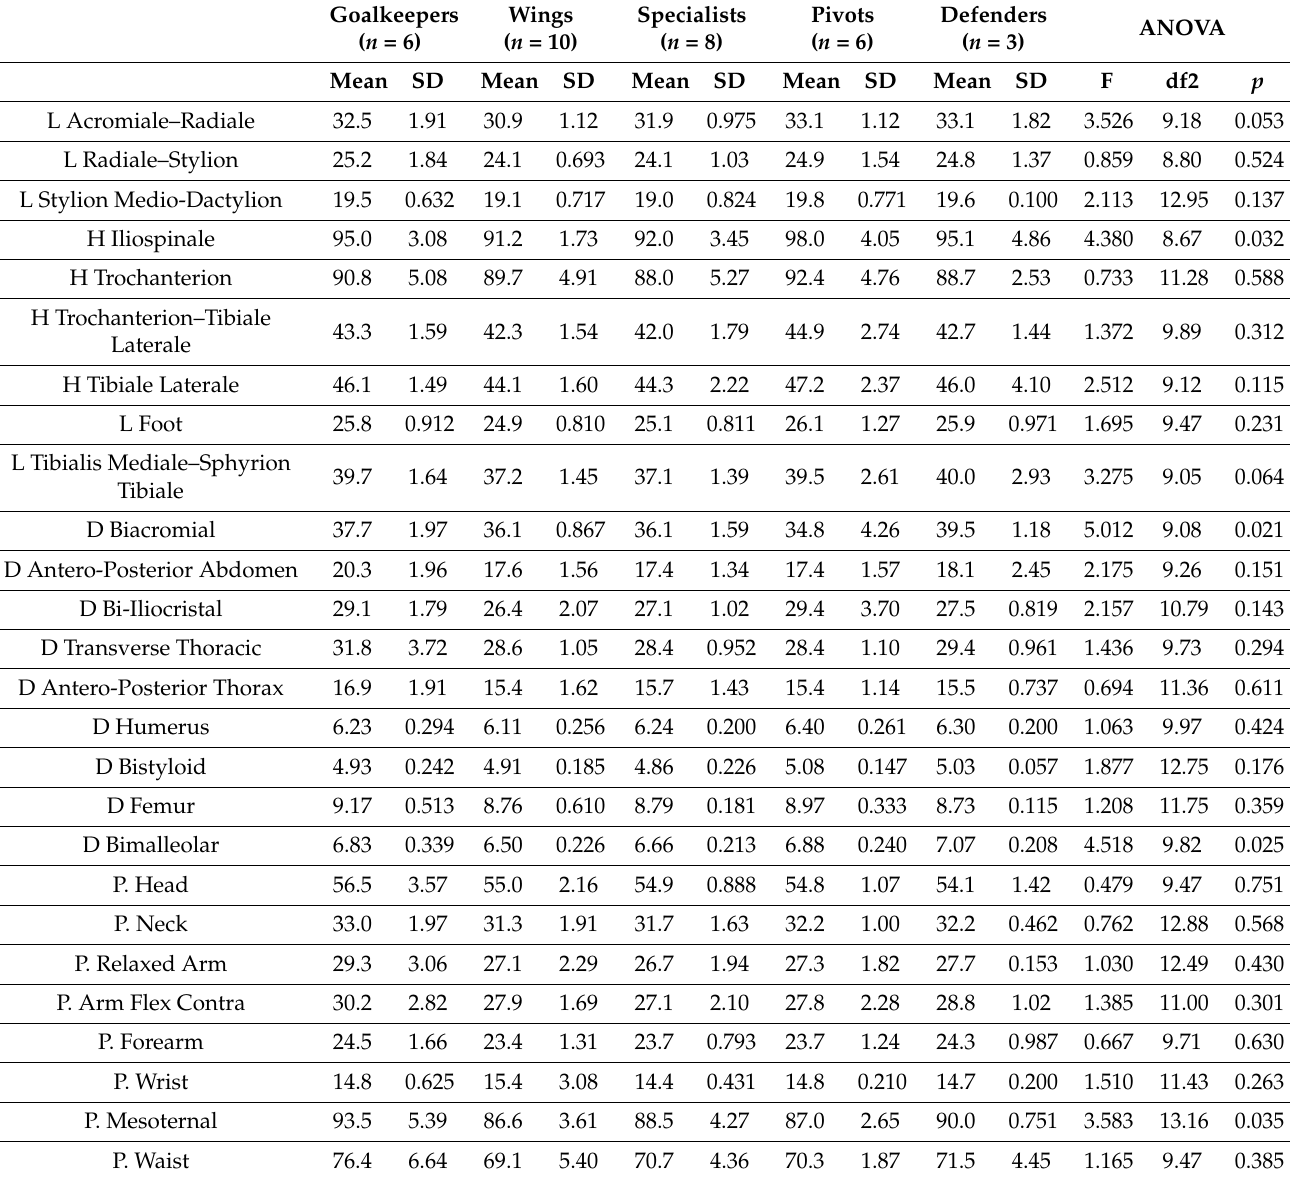
Table 6. Lengths, heights, diameters, perimeters and skinfolds depending on the playing